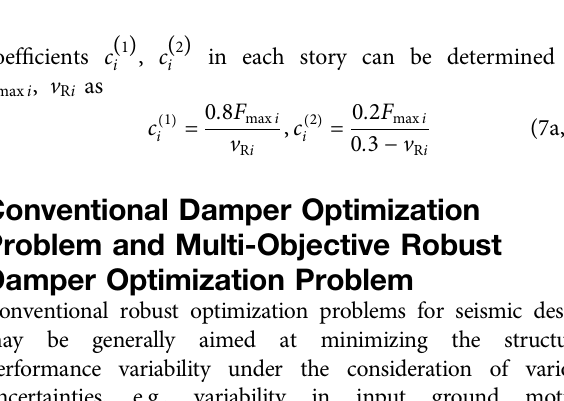
Frontiers in Built Environment |